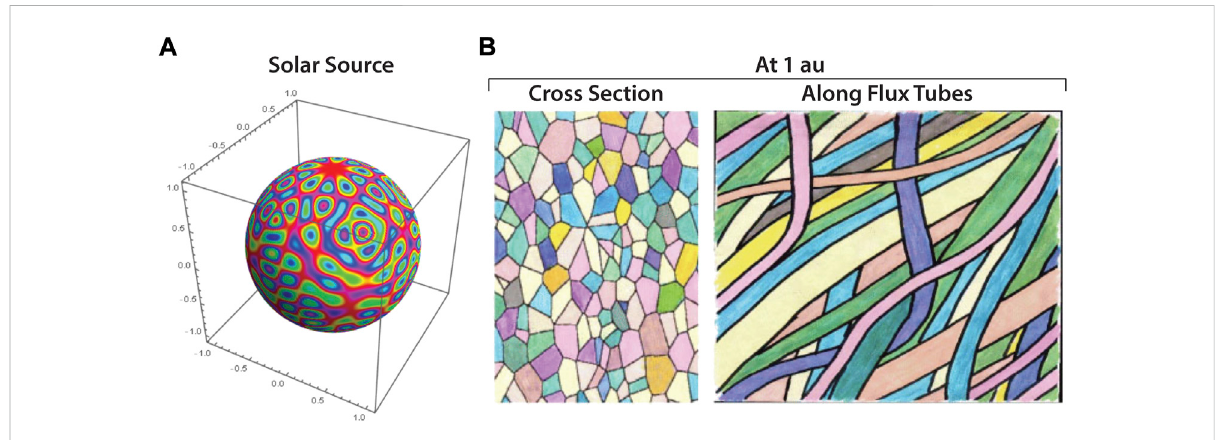
FIGURE 1 (A) Modeled representation of typical topology of magnetic structures on the solar surface (adapted from Bian and Li, 2021). (B) As these structures convect outward to 1 au, they can undergo processes such as expansion and stochastic meandering, but may preserve their characteristicsasgranuletosupergranulerelicsontheSun(cartoonadaptedfromBorovsky,2008).Thenatureof fl uxtubestructureat1auremainsa fundamental open question.